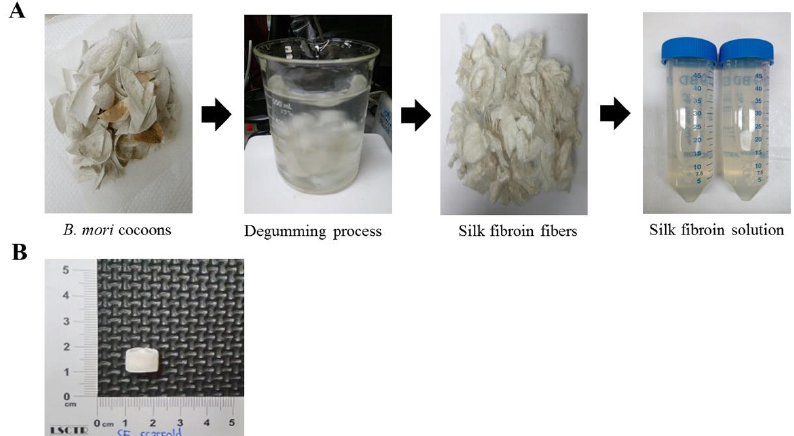
Figure 1. Preparation of silk fibroin (SF) scaffold. ( A ) Preparation of SF solution; ( B ) macroscopic appearance of the SF scaffold fabricated by a lyophilization method.